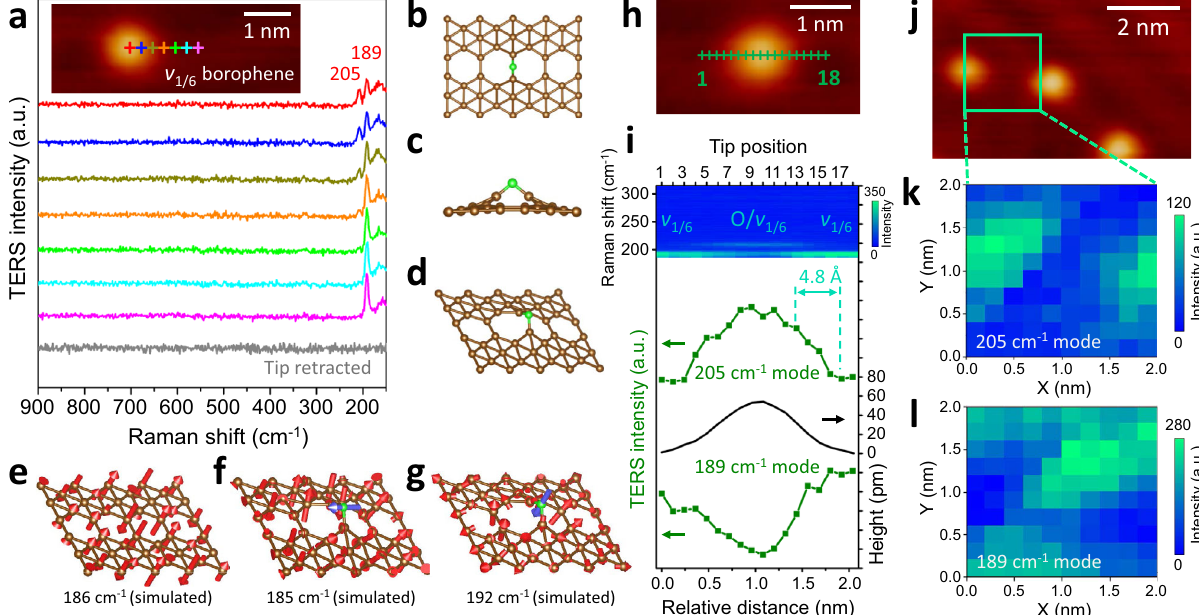
Fig. 2 Angstrom-scale chemical identi fi cation of single oxygen adatoms on borophene via UHV-TERS. a TERS line scan across the interface of an oxygen adatom on v 1/6 borophene along the trace marked with colored pluses in the inset STM image. b Top, c side, and d oblique views of the most energetically stable con fi guration of single oxygen adatoms (green spheres) on v 1/6 borophene. e Atomic displacements of the B 2 Raman mode of pristine v 1/6 3g borophene. f , g Atomic displacements of Raman modes of O-adsorbed v 1/6 borophene. Green spheres and blue arrows represent oxygen atoms and their displacements, respectively. Waterfall plot of TERS line scan ( i ) across an oxygen adatom along the green trace shown in h . TERS intensity pro fi les (green) of the 205 and 189 cm − 1 modes and the corresponding height pro fi le (black) of the oxygen atom are shown, indicating a chemical spatial resolution of ~ 4.8 Å. 2D TERS intensity mapping of the 205 cm − 1 ( k ) and 189 cm − 1 ( l ) modes over the region marked by a green square in j . TERS measurement parameters: a 0.1 V, 2 nA, 5 s acquisition time per point with a step length of 2.4 Å; i 0.1 V, 3 nA, 5 s per point with a step length of 1.2 Å; k , l 0.1 V, 3 nA, 3 s per pixel with a step length of 2.0 Å. All STM images were acquired at a sample bias of 1.5 V and a tunneling current of 300 pA. a.u., arbitrary